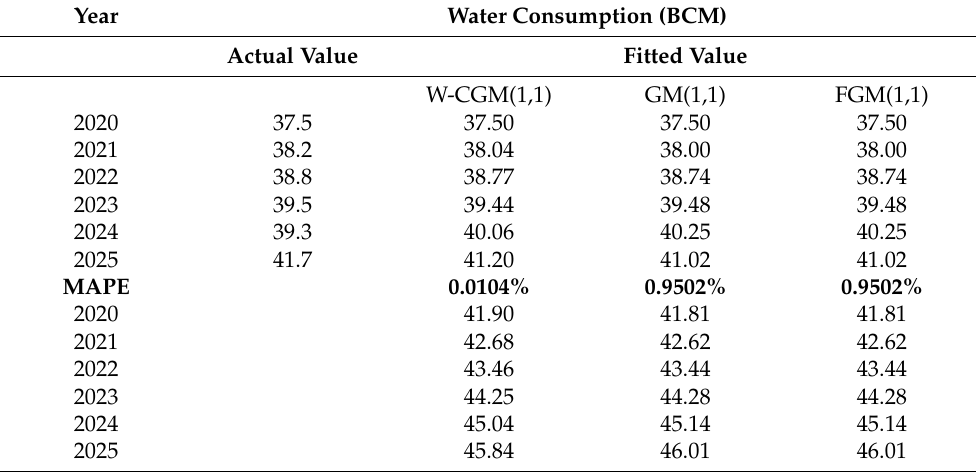
Table 6. Water consumption in Beijing from 2020 to